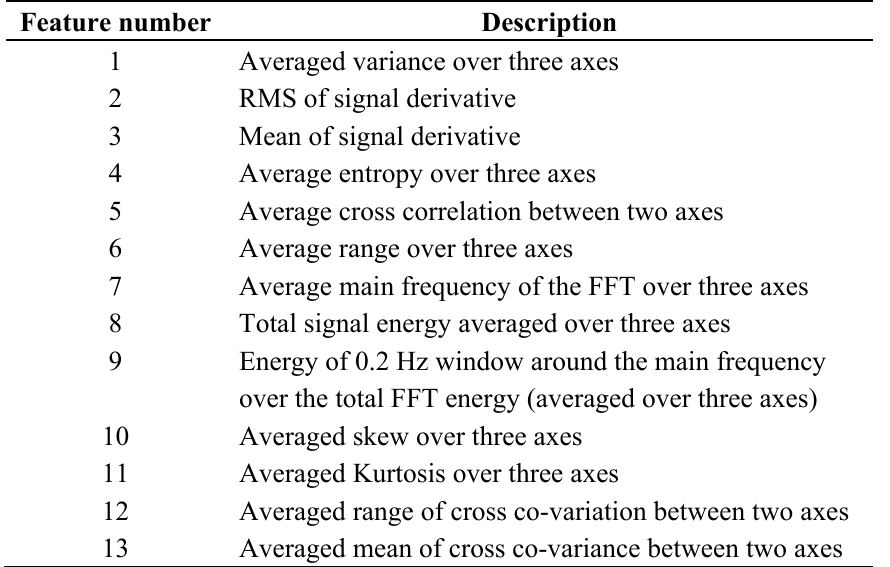
Table 12. Optimal features for ambulation, posture and transfer ADL